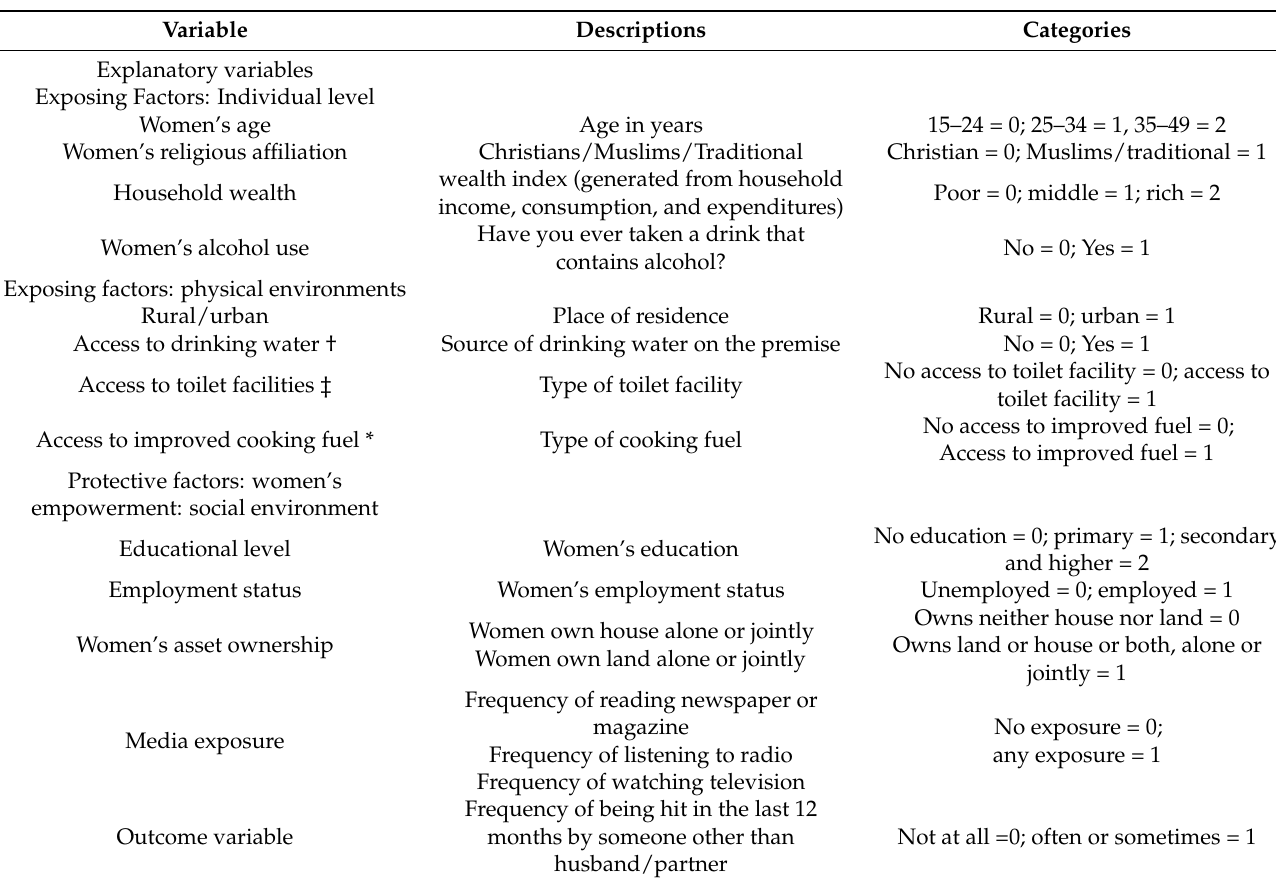
Table 1. Variable description and